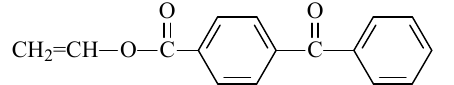
Figure 6. The structure of acryloylbenzophenone.